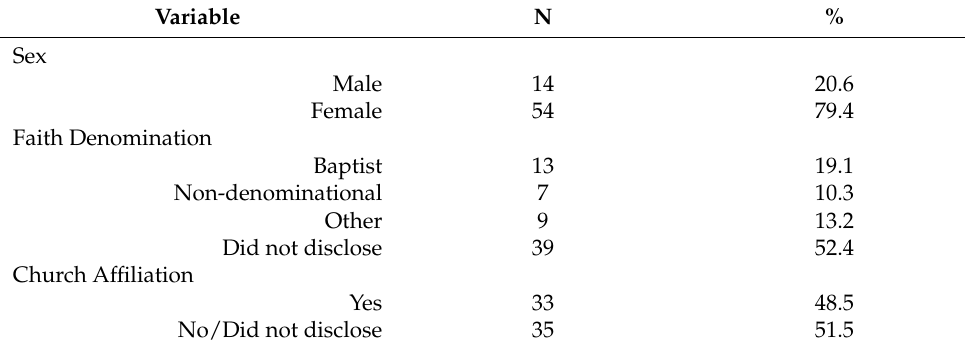
Table 2. Key characteristics of Faith Summit registrants (n =